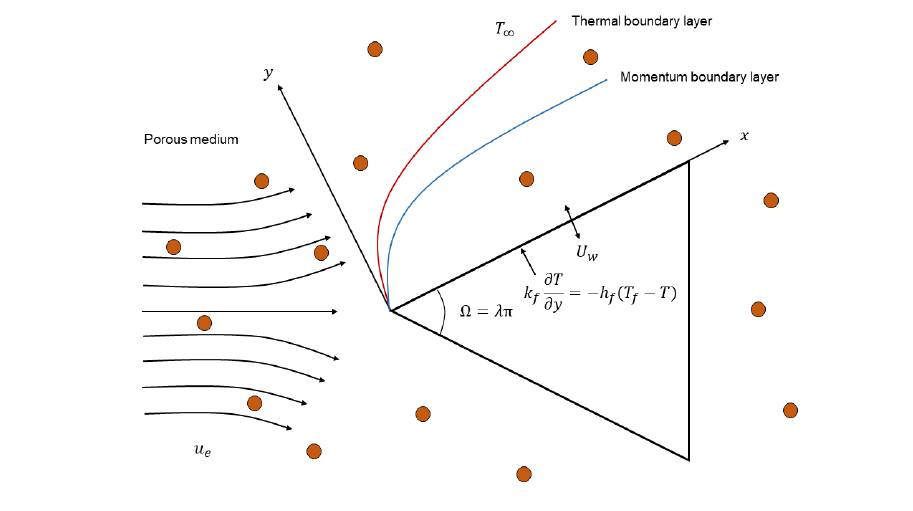
Fig. 1. Physical model and coordinate